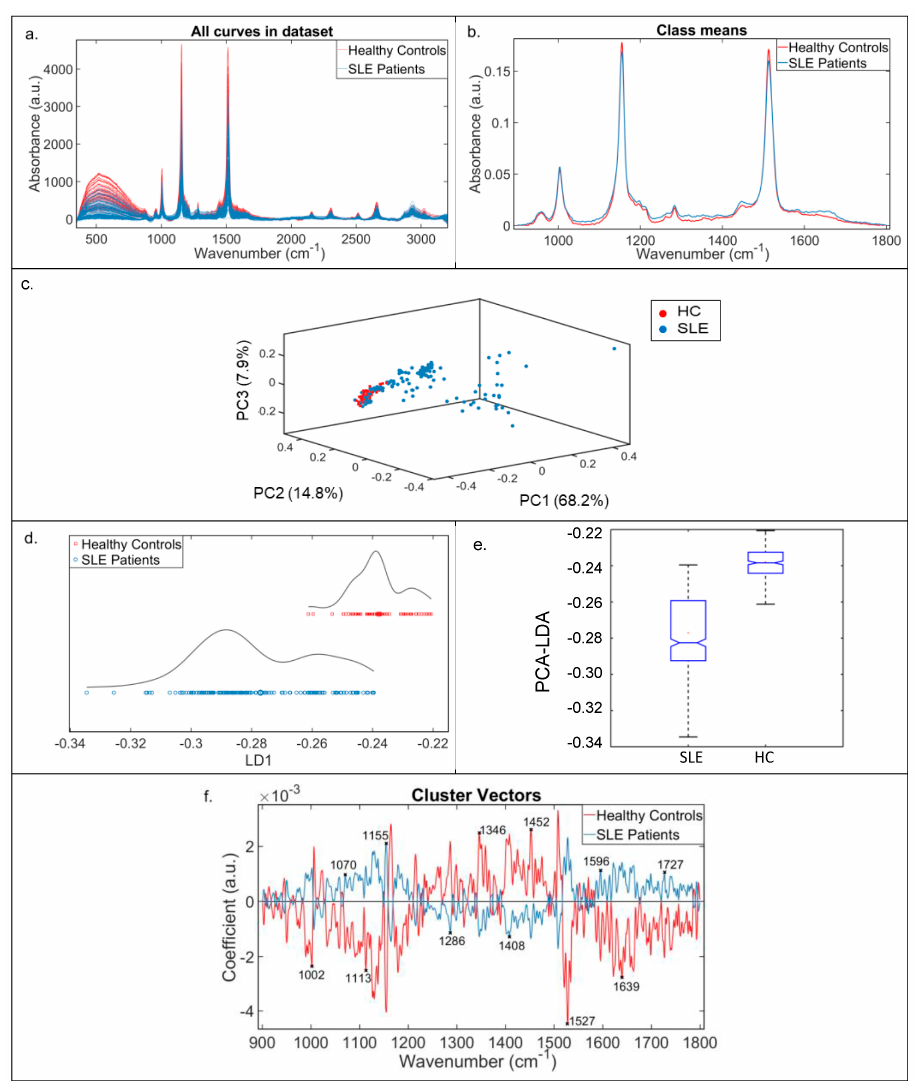
Figure 1. Raman spectral data for SLE patients (SLE) vs. healthy controls (HC) for serum samples. ( a ) All raw spectra curves of healthy controls (red) and SLE patients (blue). Whole region of wavenumbers (400–3500 cm − 1 ) against the absorbance intensity (a.u). ( b ) Average rubber band, vector normalised pre-processed Raman spectra cut to biological fingerprint region (900–1800 cm − 1 ). ( c ) The 3D PCA scatterplot. Pre-processed Raman data using PC1, PC2 and PC3. The 3D scatterplot shows separation of healthy control (red) and SLE (blue). ( d ) PCA-LDA discriminant scores. Score plots show clear separation of groups, healthy controls (red) and SLE patients (blue) ( p -value < 0.0001). ( e ) Box plot for healthy controls (HC) and SLE patients. Mean and IQRs illustrated in boxes; SDs displayed in whiskers. ( f ) PCA-LDA cluster vector analysis. Cross-validated cluster vector anal- ysis demonstrates discriminating peaks between healthy controls (red) and SLE patients (blue). The top 12 discriminating peaks are labelled with their wavenumber. IQR—Interquartile range; SD— Standard deviation.